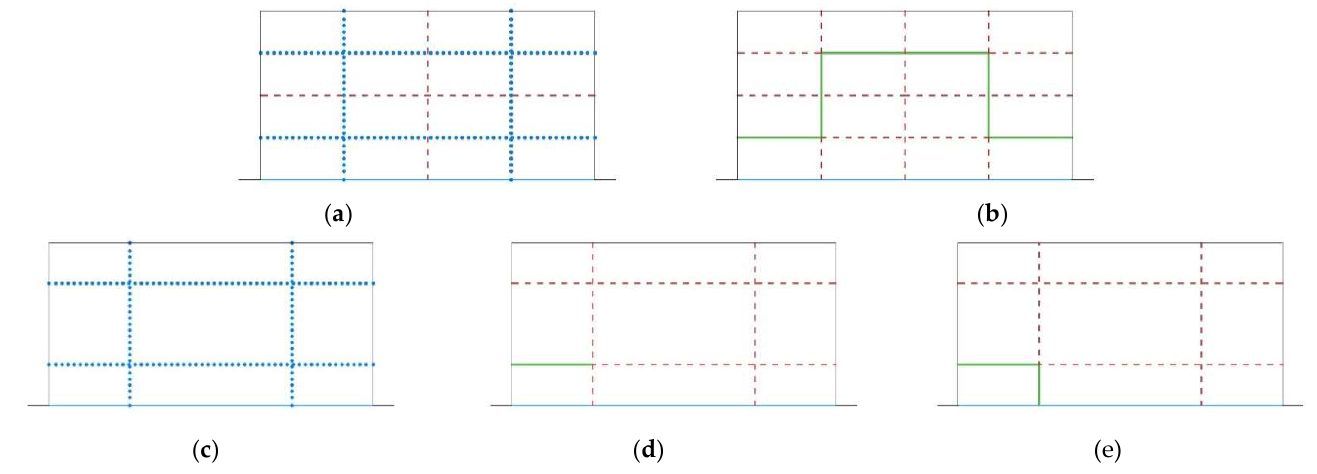
( c ) Figure 6. ( a ) The optimization result with limit analysis for the 2D problem generating two seg- ments, including: ( b ) the load factor and the internal forces (in Newton) and moments (in Newton- meter); ( b ) the shear strength at each interface. Capital letters A and B are used to enumerate the segments.